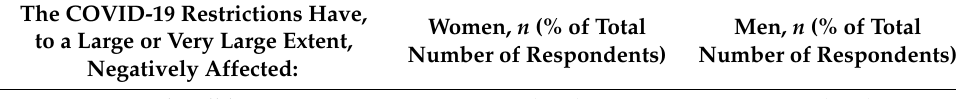
Table 7. The negative effects of the COVID-19 restrictions among women and men in the anony- mously completed self-report survey in the Faroe Islands conducted from 13 April until 4 May 2020, n = 1328.